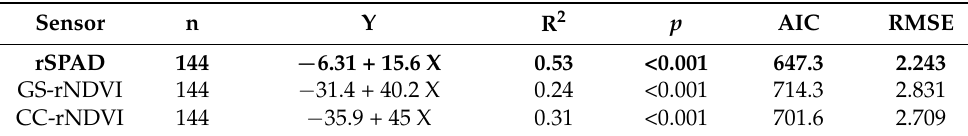
Table 6. Sensor comparison between the relative VI values for the SPAD, GreenSeeker, and Crop Circle sensors. Data were collected at the VT stage from the Brooksville, Starkville, and Verona 2020 sites. The best fit sensor based on R 2 , AIC, and RMSE is bolded.